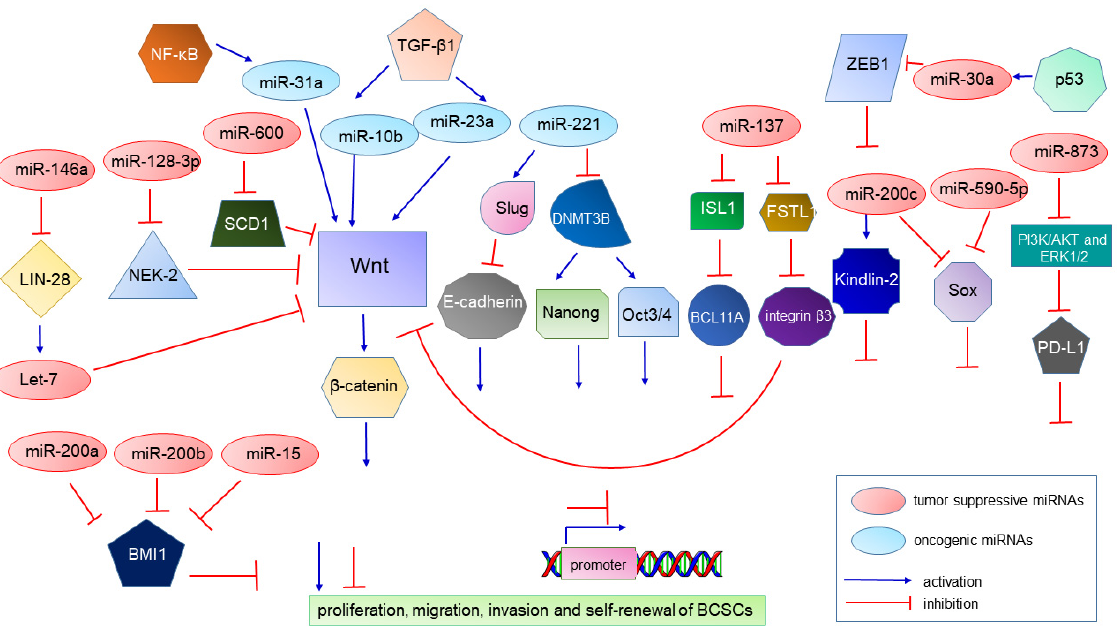
Figure 2. Schematic drawing representing the interplay between miRNA and protein involved in epigenetic regulation and tumorigenesis of BCSC.